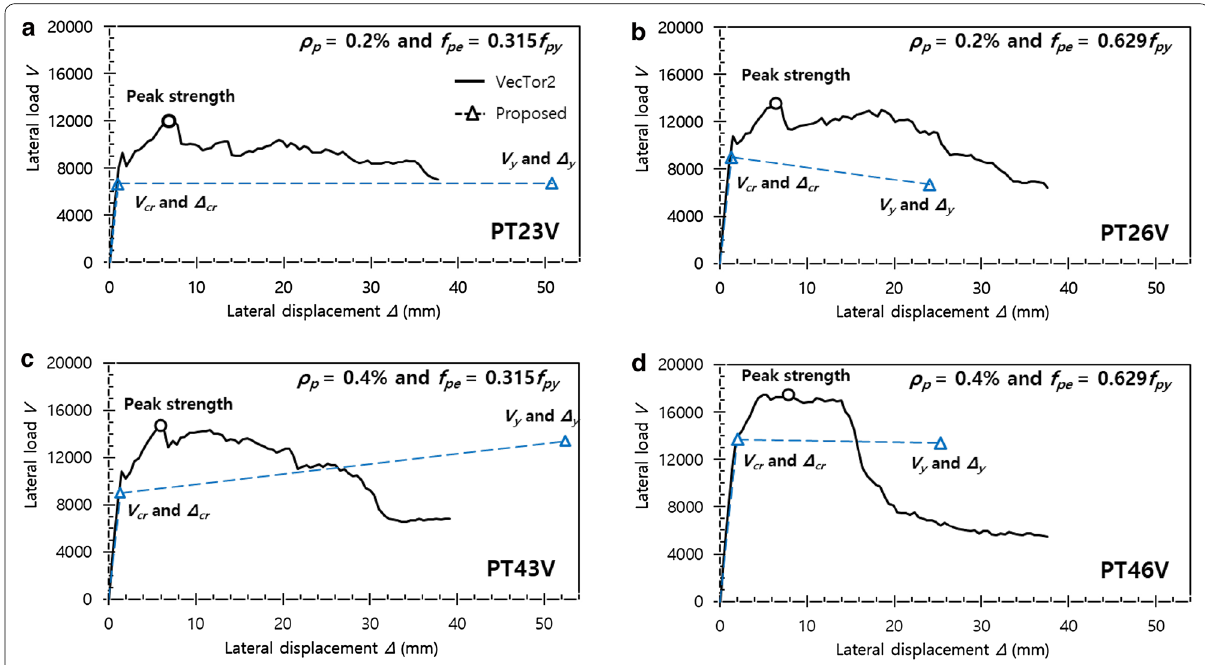
Fig. 14 Lateral load–displacement relationships by FE